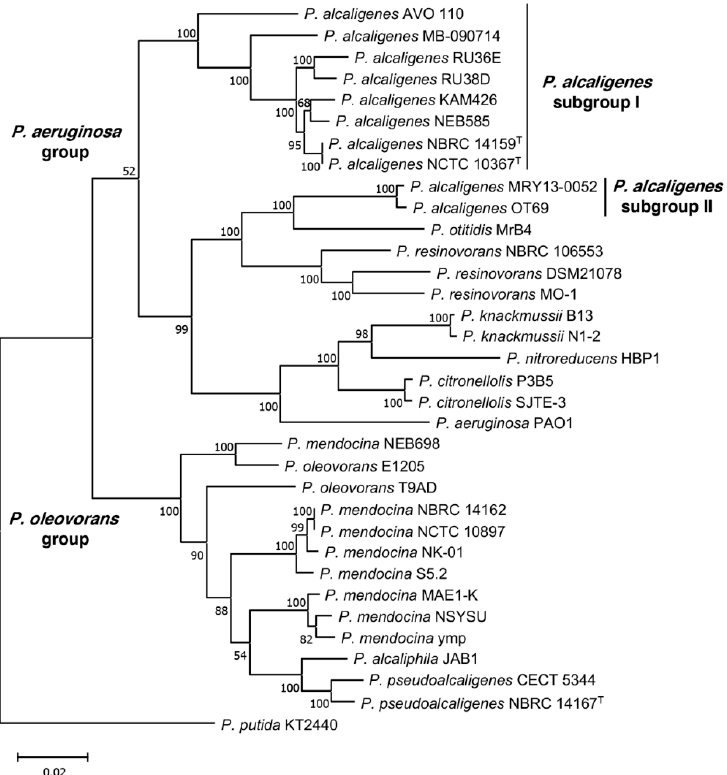
Figure 1. Phylogenetic analysis based on core genome of 34 species belonging to P. aeruginosa and P. oleovorans groups. The tree was built using MEGA7 [54] and maximum likelihood method with 100 bootstraps. Sequences were downloaded from NCBI and P. putida KT2440 was used as an external group. Values in nodes indicate percentages of bootstrap. Super- script T indicates type strains; P. alcaligenes NCTC 10367 and P. alcaligenes NBRC 14159 are the same strain deposited in two different collections.